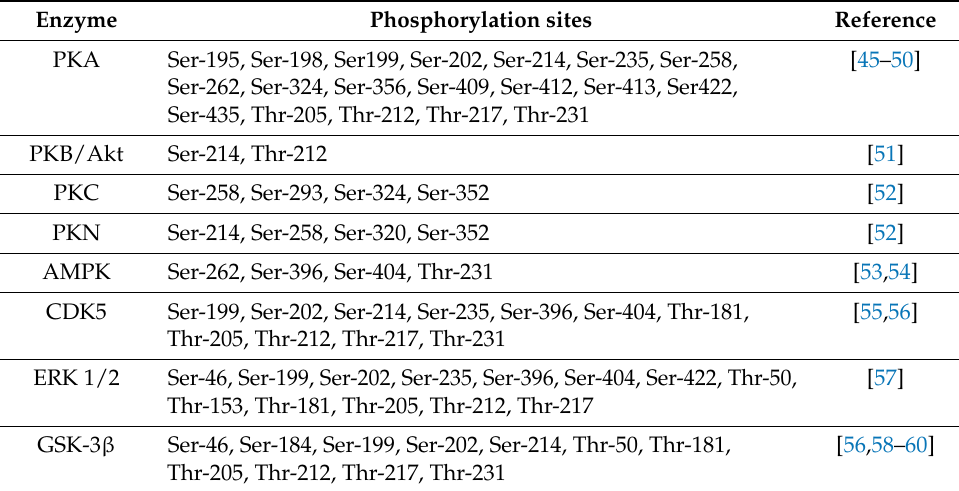
Table 1. Some major enzymes and their sites of Tau